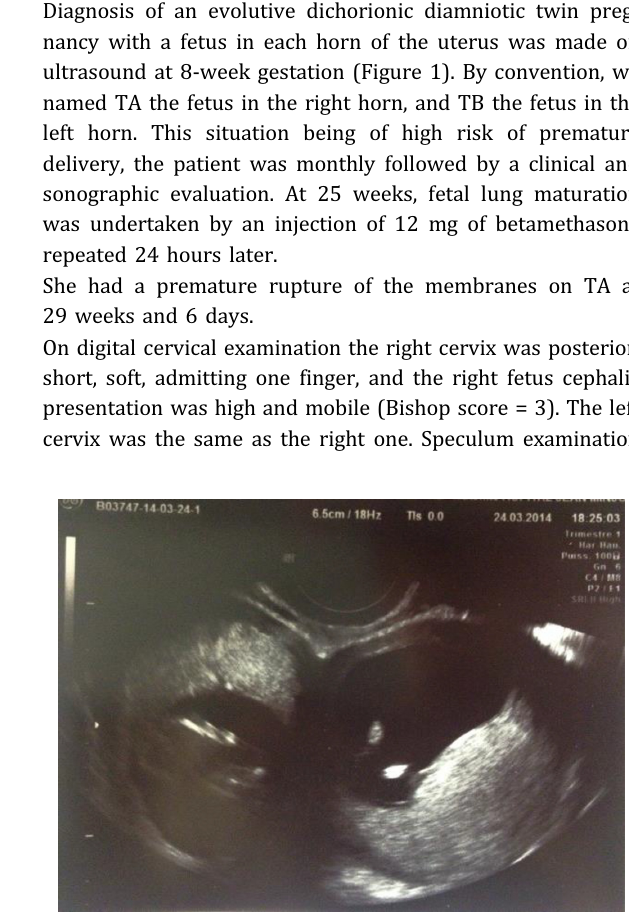
Figure 1 . Ultrasound at eight gestational